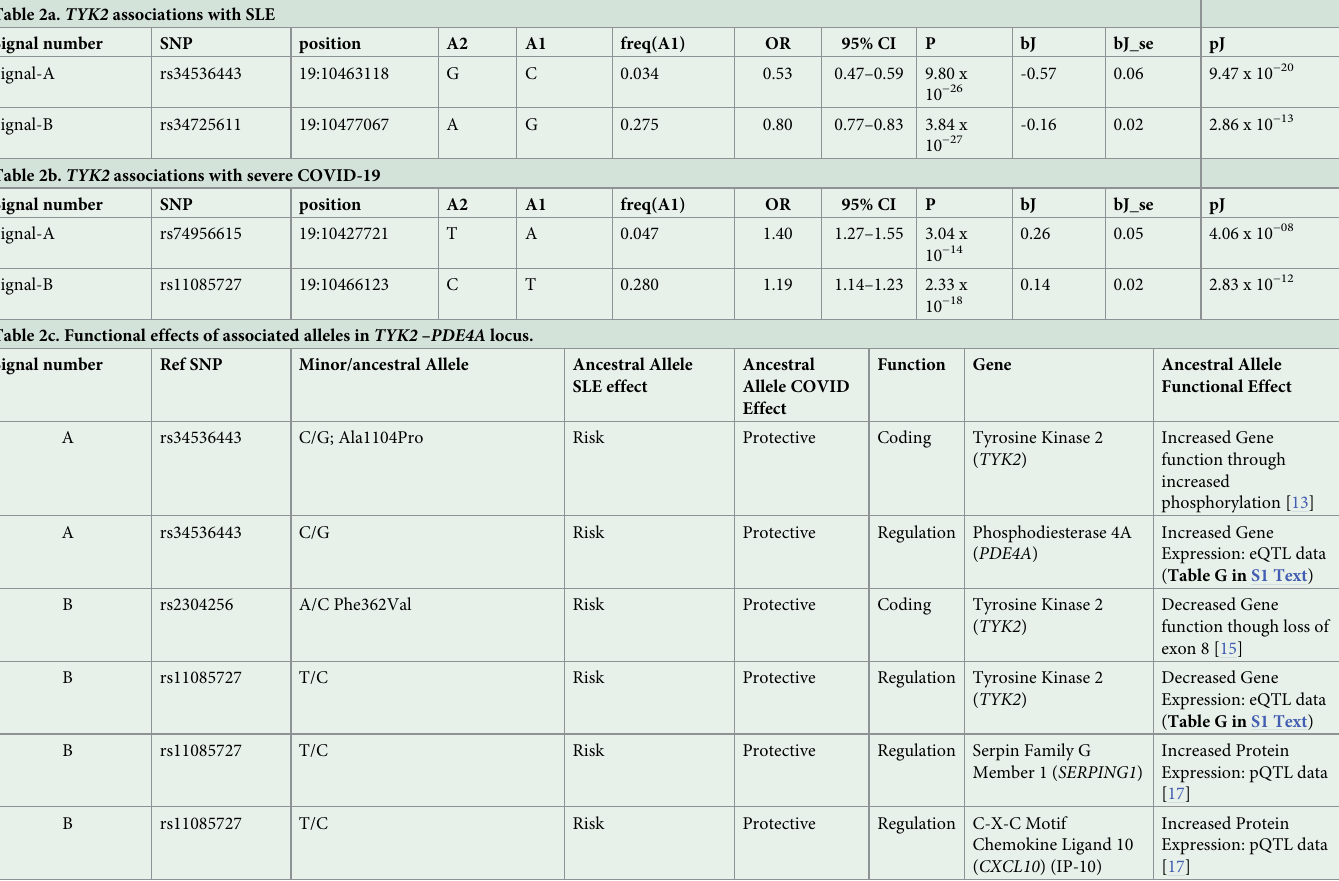
( Table G in S1 Text